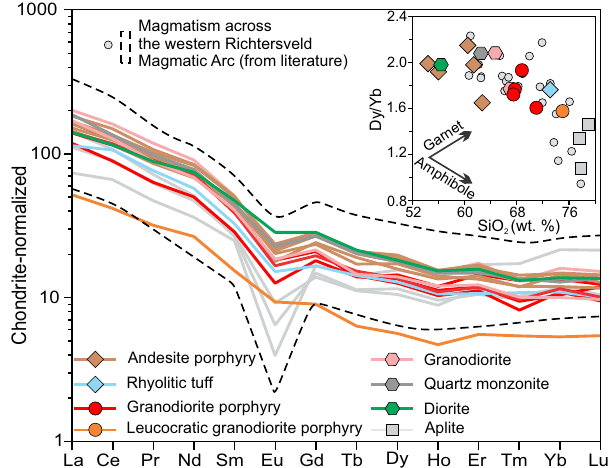
Fig. 2 Chondrite-normalized rare-earth element spider diagram for igneous rocks from Haib. The normalization values are from ref. 84 . Inset is Dy/Yb versus SiO 2 diagram, and the fractionation trends of amphibole and garnet are from ref. 42 . Data for the igneous rocks (LOI ≤ 2 wt.%) from the western Richtersveld Magmatic Arc were compiled in ref. 15